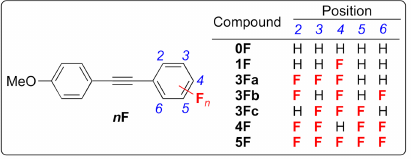
Figure 2. Molecular structures of the fluorinated tolanes used in this